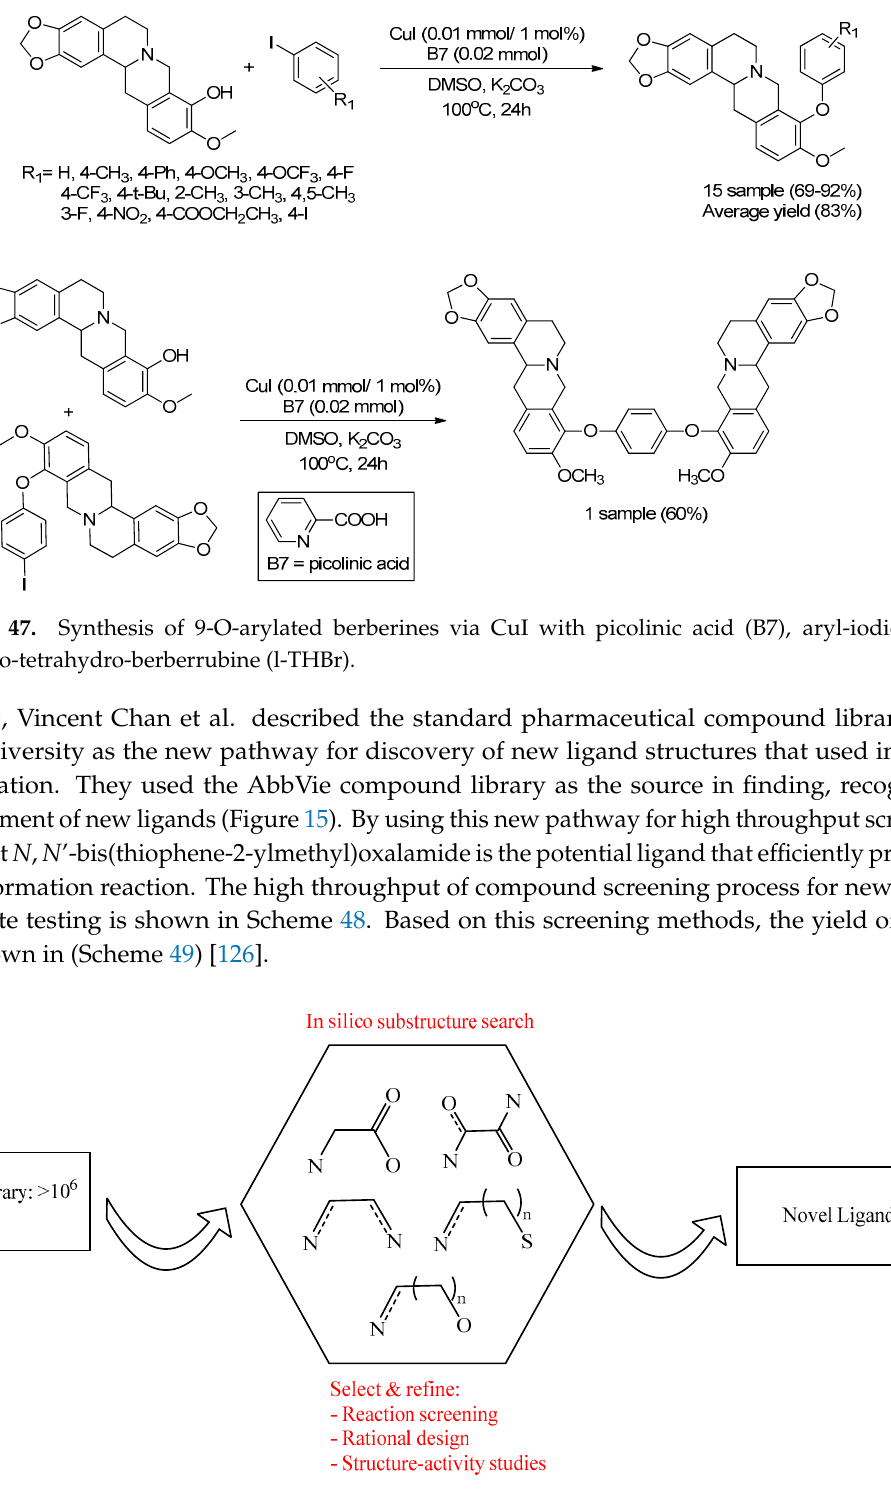
Figure 15. Method for utilizing the AbbVie compound library as an origin for finding, recognition, and development of new ligands.